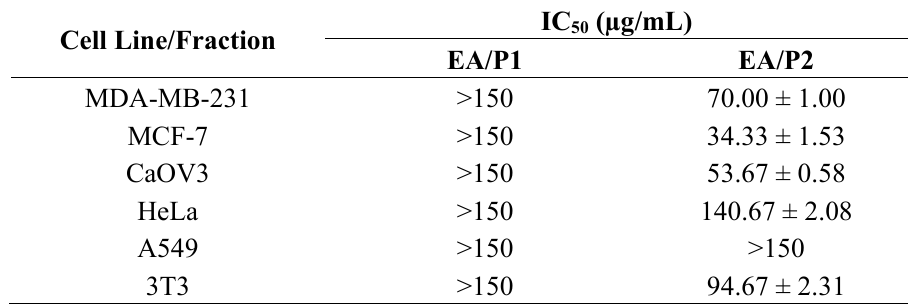
Table 2. Cytotoxicity of EtOAc fractions of D. suffruticosa on selected cancer cell lines.